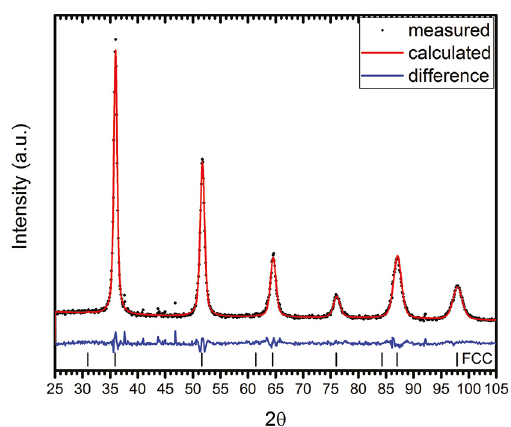
Figure 3: Neutron powder diffraction patterns of hydrided 52Ti-12V-36Cr+4%wt. Zr